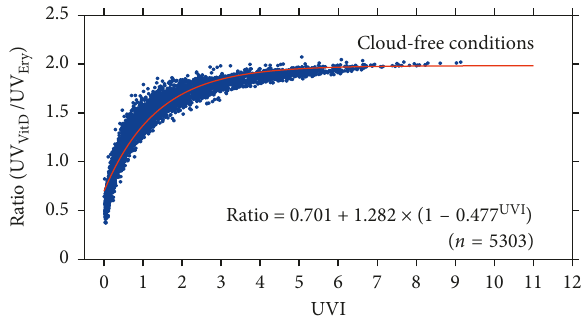
Figure 6: Relation between the R UV and UVI from the hyper- spectral observation of the Brewer spectrophotometer in Seoul (2006 ∼ 2010) in clear-sky